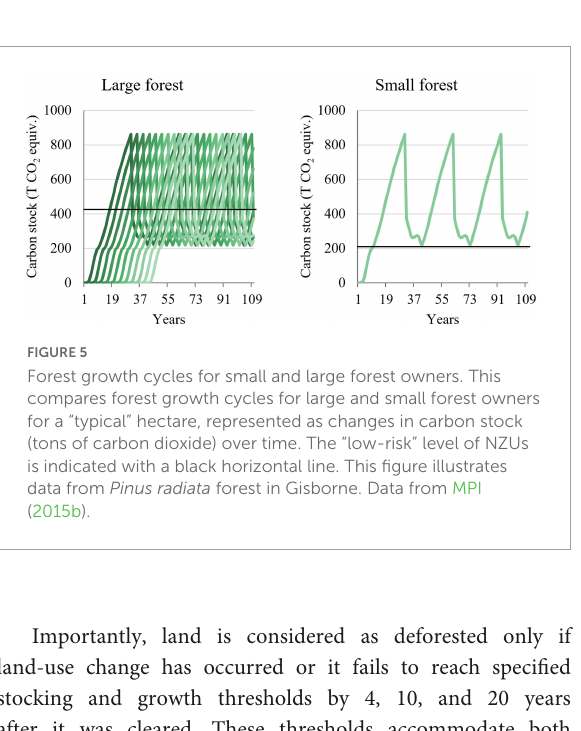
Frontiers in Forests and Global